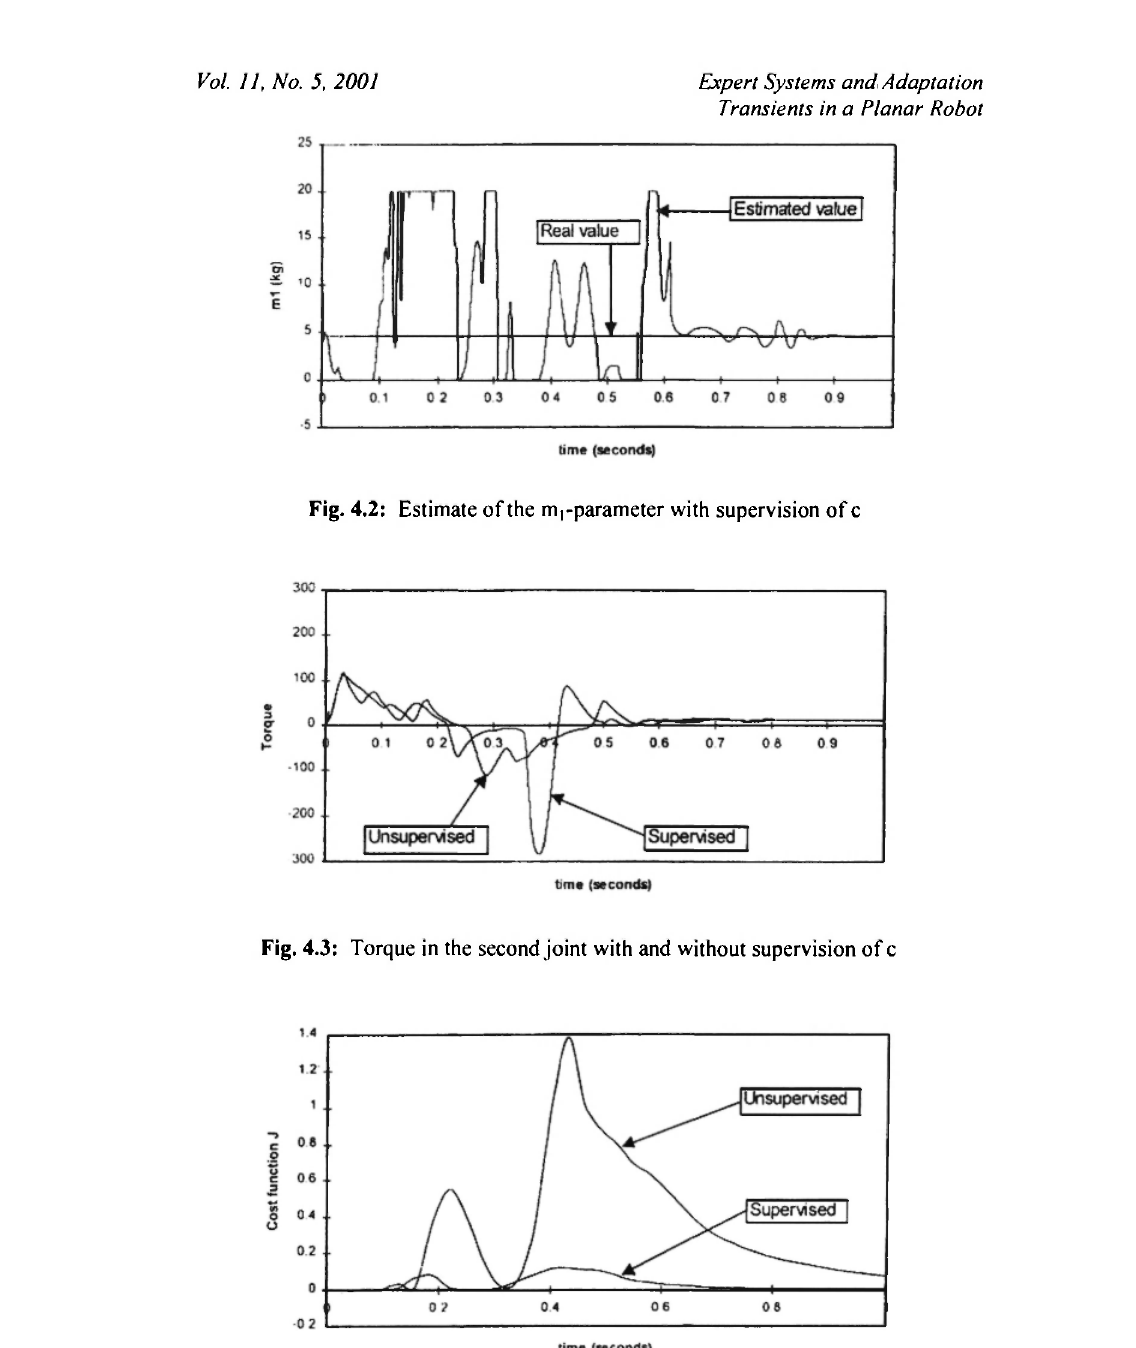
Fig. 5.1: Cost function J with and without